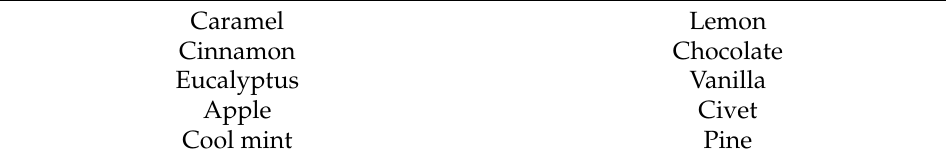
Table 8. Olfactory stimuli used during our implicit association